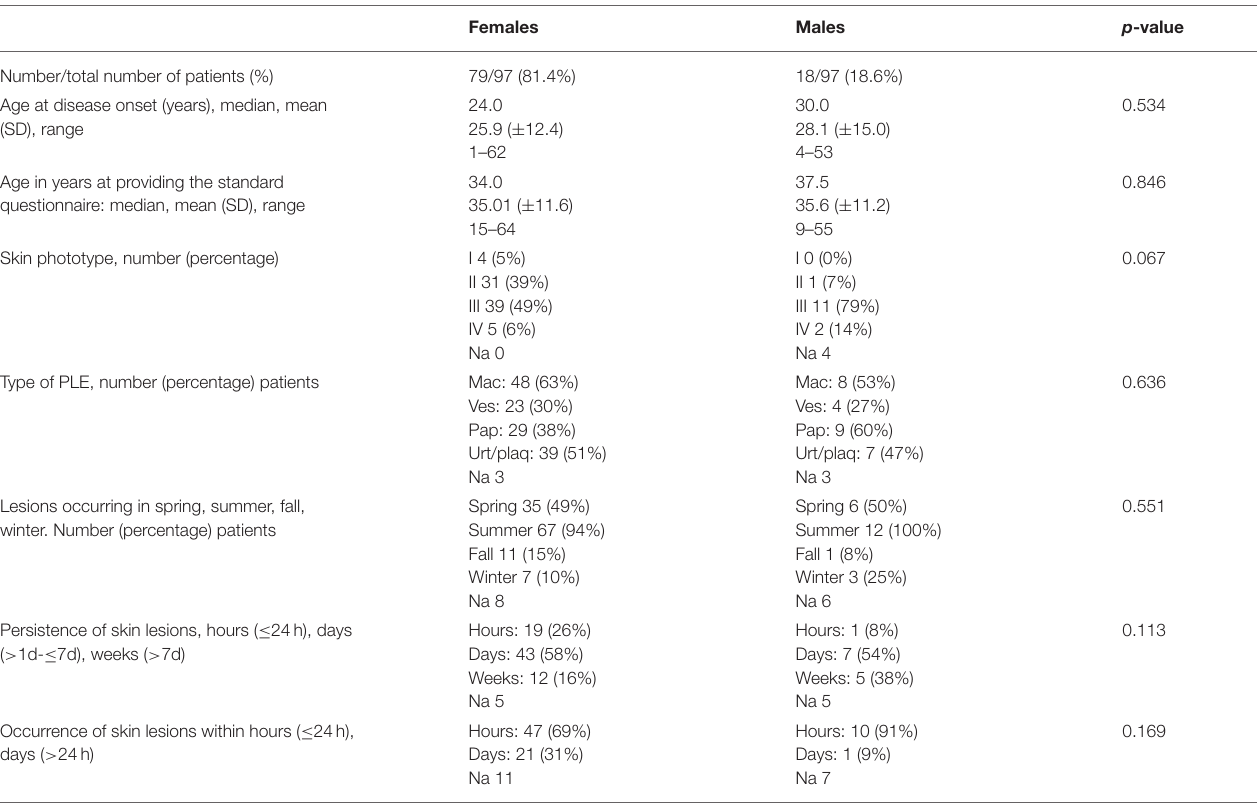
TABLE 1 | Patient characteristics. Females Males p -value Number/total number of patients (%) 79/97